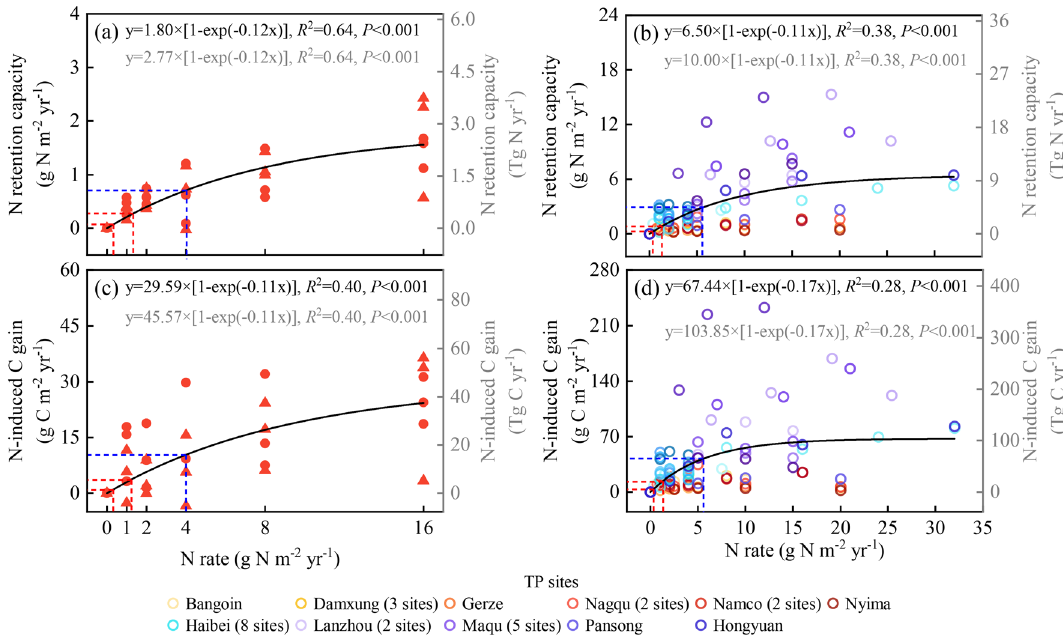
Figure 4. Effects of N addition on N retention capacity and N-induced C gain. ( a , c ) N retention and C gain of Namco field experiment in 2011 (circle points) and 2015 (triangle points). ( b , d ) N retention and C gain of Tibetan Plateau (TP) experiments in the data synthesis. The left axes indicate the annual N retention and C gain per unit area of the TP. The right axes indicate the total N retention and C gain of the TP per year (based on 1.54 million km 2 of grassland on the TP). Single regression analyses were implemented. Full regression results are shown in Appendix S2: Table S7. The red dashed line indicates N retention and C gain of Namco and the entire TP grassland at the current rate of N deposition (0.32–1.23 g N m −2 yr −1 ). The blue dashed line indicates N retention and C gain under the future N saturation rate (at the N cr of 5.53 g N m −2 yr −1 ).